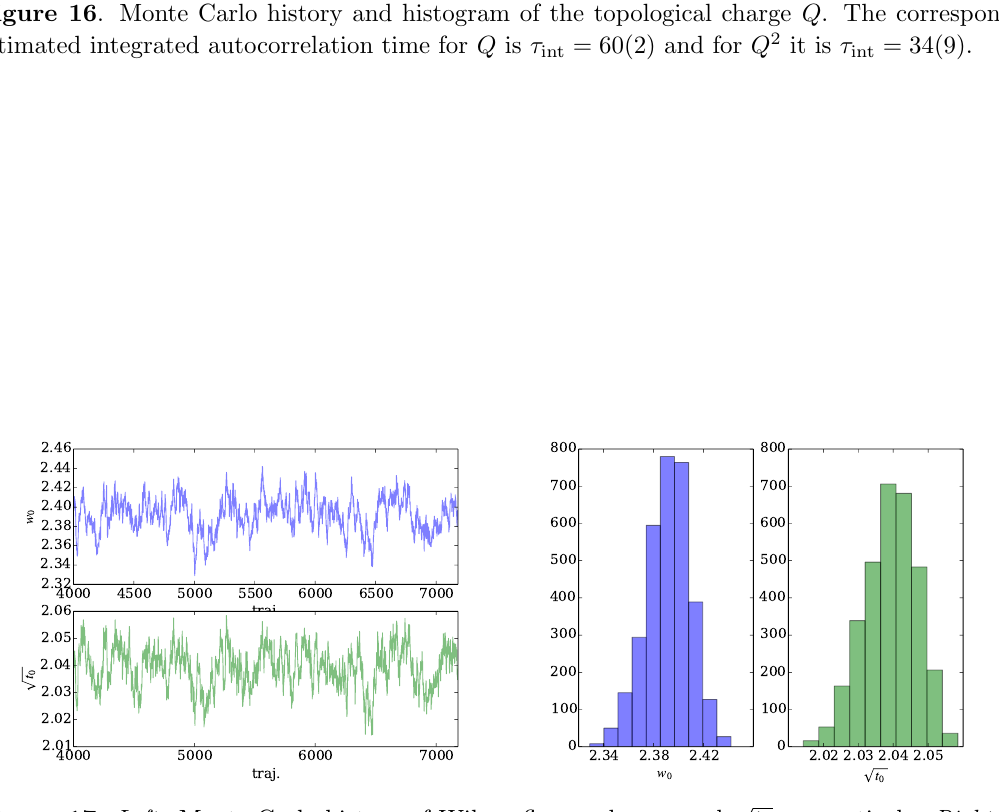
p t 0 , respectively.